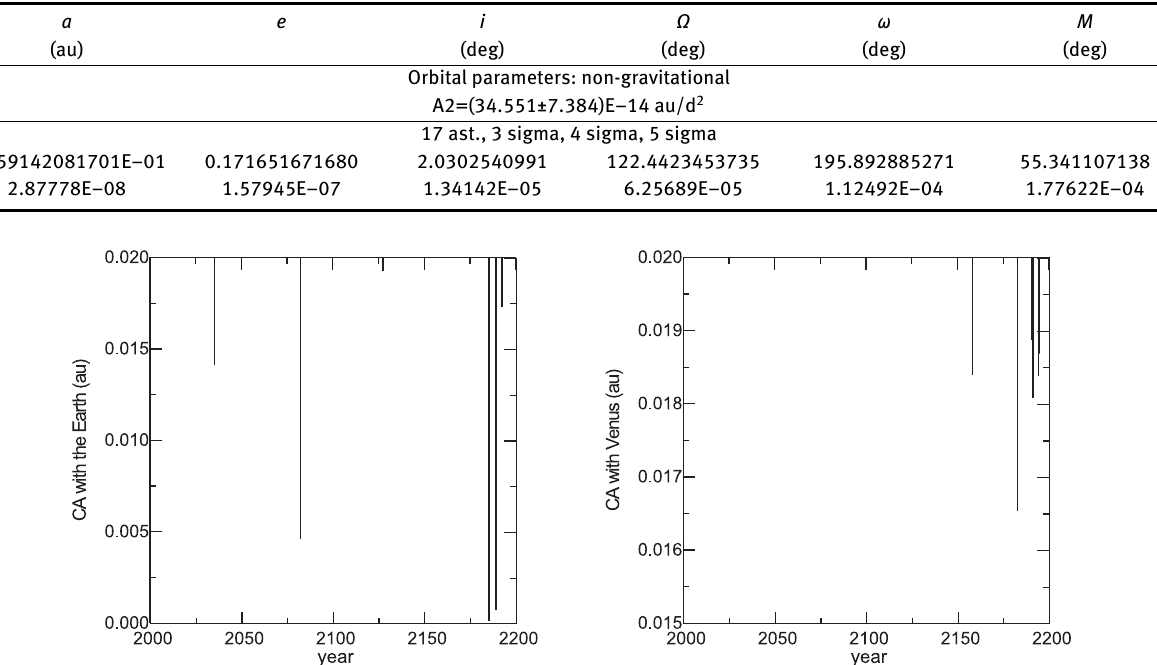
Table 1. Initial nominal orbital elements of the asteroid 2001 BB16: a denotes semimajor axis, e - eccentricity, angles i , Ω and ω refer to the Equinox J2000.0, M - mean anomaly. Epoch: 2018-March-23=JD2458200.5 TDB. Orbital elements are computed with non-gravitational parameter A 2 and for different value of sigma .